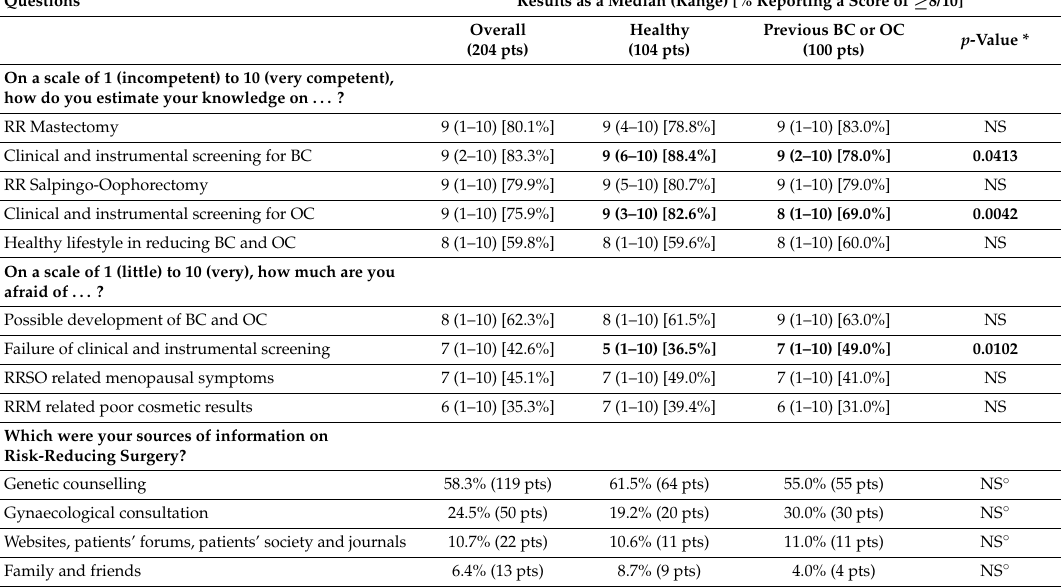
Table 2. Results of carriers’ survey on knowledge and concerns on Risk-Reducing Surgery and screening procedures, considering their medical history (healthy one versus those who had a previous Breast or Ovarian